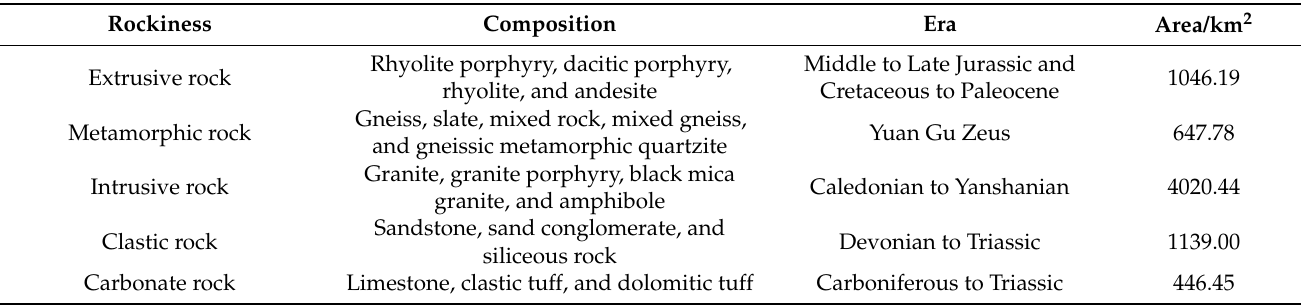
Table 1. Classification of geotechnical types in